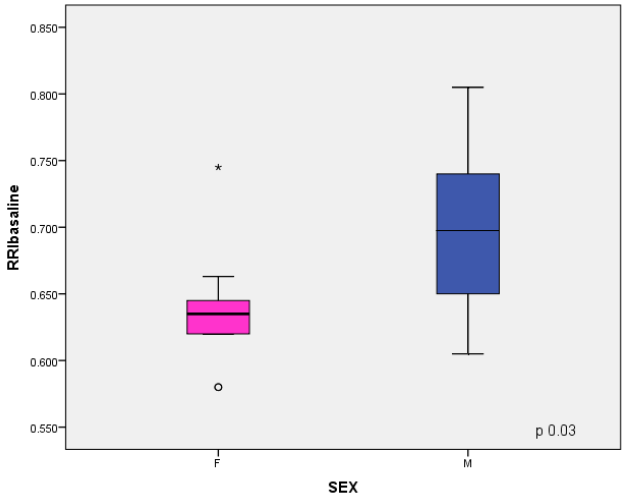
Figure 4. RRI in male and female patients. Box plot showing the differences of RRI baseline between male and female subsamples. Comparison with Student’s t -test for independent samples showed that males had higher baseline RRI values than females. * and ○ are two extreme values.